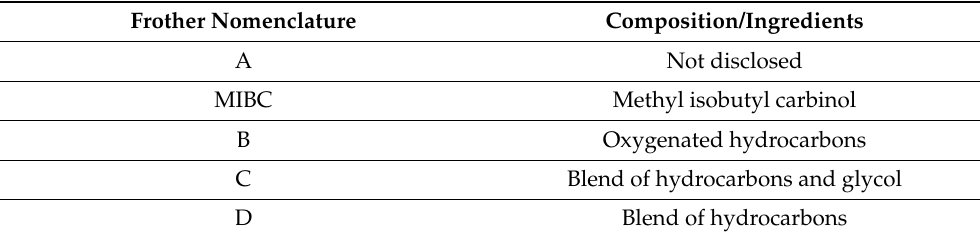
Table 1. Compositions of frothers under the study.